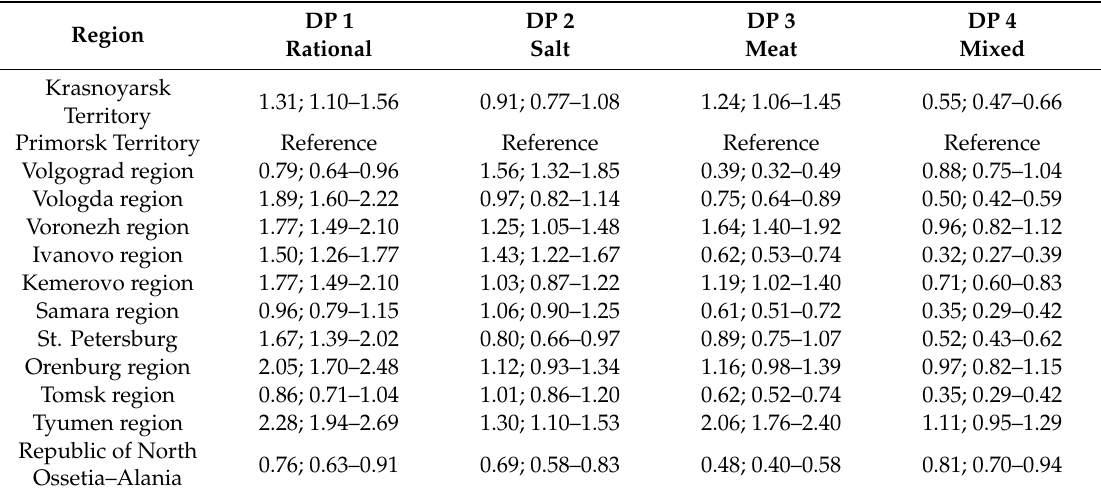
Table 6. Multivariate associations of socioeconomic and demographic variables with dietary